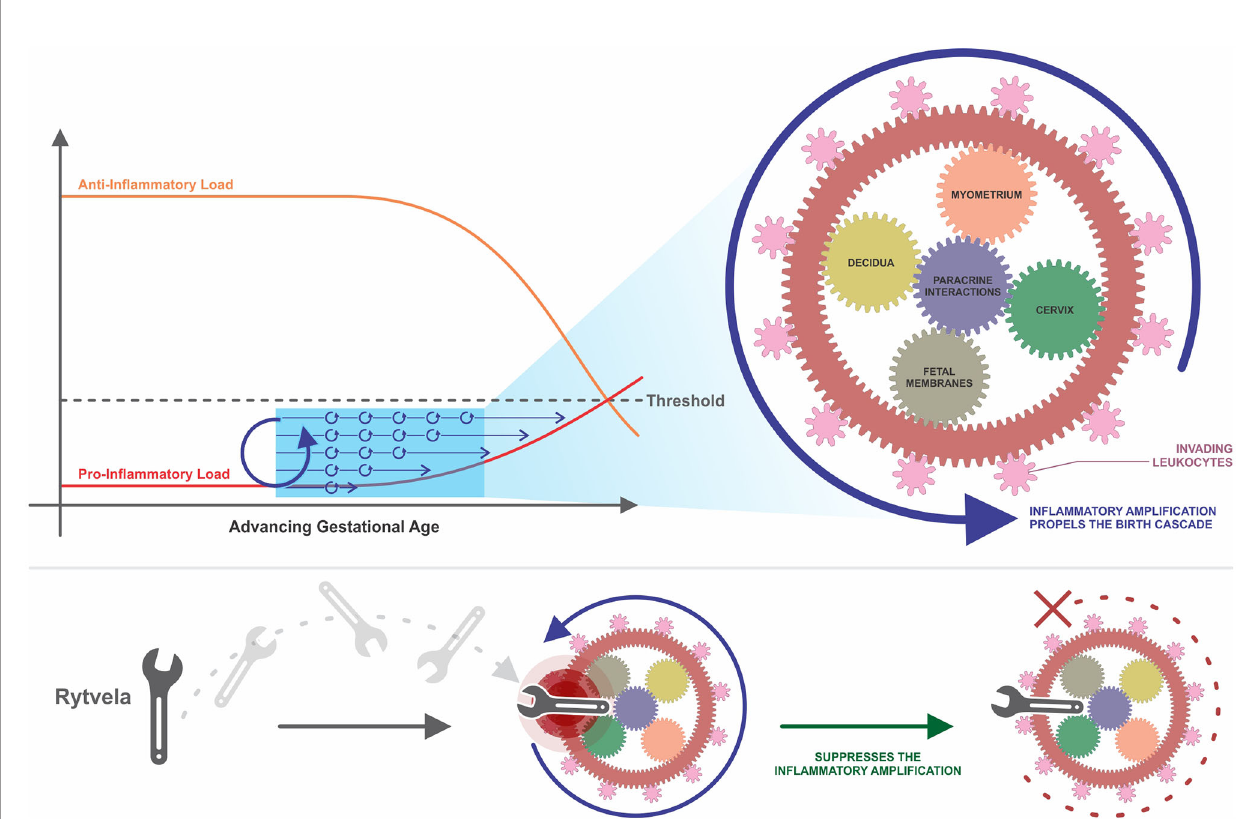
FIGURE 2 | A conceptual framework of uterine transition. This framework incorporates the concepts of MAPS and anti- and pro-in fl ammatory load introduced by Mitchell and Taggart, (2009), Talati et al. (2017), and Keelan (2018). Parallel up-regulatory events accumulate over time, driven by paracrine interactions between various cells and tissues in the intrauterine environment. Ampli fi cation occurs within and between these pathways, which begins to propel the momentum of the larger wheel. The pro-in fl ammatory load continues to build while the anti-in fl ammatory load, such as the progesterone blockade, diminishes. These two loads ultimately approach each other, creating a threshold value that once crossed, triggers irreversible labor and parturition at term or preterm. Once labor is established, the gearwheel is moving with an inertia too powerful to be stopped with existing tocolytic therapies. An ef fi cacious anti-in fl ammatory intervention, such as rytvela, is essentially a spanner in the works that suppresses the upstream process of in fl ammatory ampli fi cation and thereby slows the turning of the wheel before it reaches top speed. MAPS, modular accumulation of physiological systems; rytvela, IL-1R allosteric